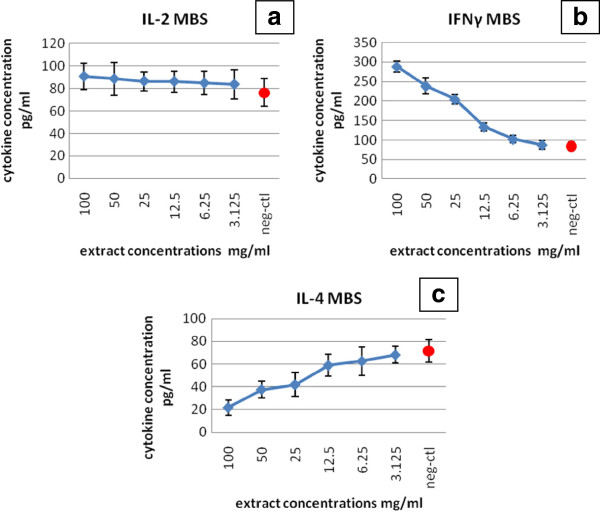
Figures demonstrate the level of the produced cytokines,in comparison with negative control (neg-ctl), in culture supernatant of peripheral blood lymphocyte cell after treatment with mung bean sprout extract (MBS): a) IL-2, b) IFN-γ and c) IL-4.